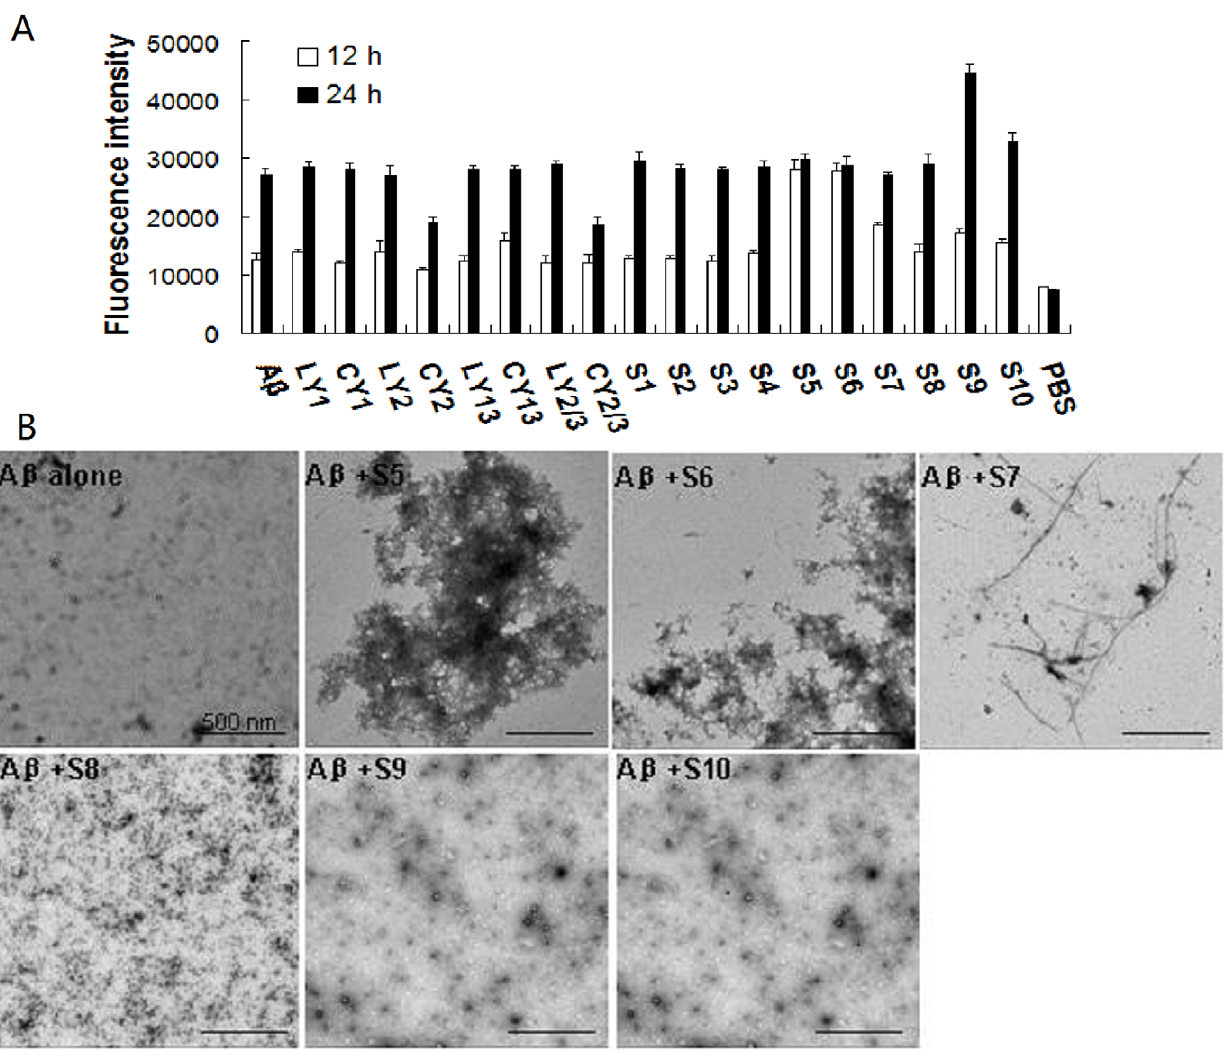
Figure 2. Effect of original and chimeric peptides on A b aggregation. (A) A b 42 (10 m M) was incubated with or without 20 m M of original or chimeric peptides for 12 or 24 h at 37 u C. ThT fluorescence intensity was measured with excitation at 450 nm and emission at 482 nm. (B) Ten m l aliquots of A b 42 incubated with or without peptides S5, S6, S7, S9, and S10 for 12 h were examined with TEM. Images were acquired at 80 kV with 5 K magnification. The scale bar is 500 nm.